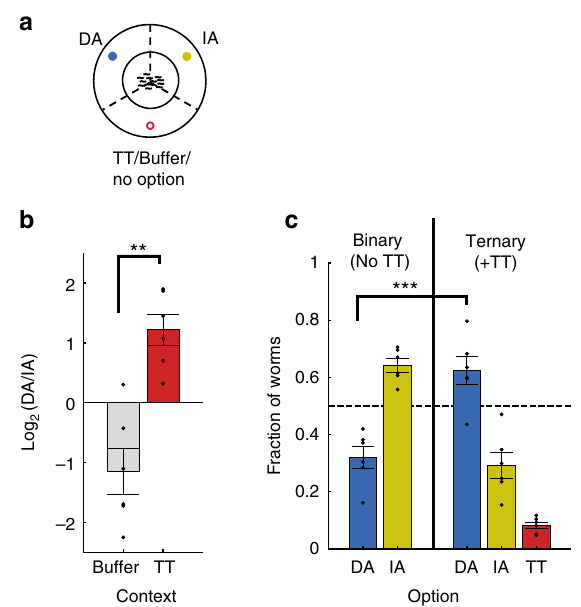
Fig. 7 C. elegans worms violate the rationality paradigms of IIA and regularity. a A diagram of the ternary choice assay. b Violation of Independence of Irrelevant Alternatives (IIA). For studying IIA, we compared preferences between two competing options (DA 7·10 – 5 and IA 10 − 1 ) where the third option was either TT 10 − 2 or buffer. The identity of the third option (TT vs buffer) changed the preference ratio between DA and IA, thus violating the constant-ratio rule 28 . In fact, it actually switched the identity of the preferred option, thus violating also choice independence of alternatives. Y axis is the log ratio between worms that chose DA and worms that chose IA. ** P < 0.005, signi fi cance of difference between buffer and TT as a third option (paired t test). Importantly, both log ratios are signi fi cantly different than 0 ( p < 0.05, t test), indicating that presenting TT, rather than buffer as a third option, switches DA/IA preference from IA to DA. c Violation of regularity. Shown are the fraction of worms selecting each option in binary and ternary choice assays. Note that expanding the set by adding TT not only increased preference towards DA but caused this preference to actually exceed 50%. ***signi fi cance of change by set expansion with P < 0.001 (paired t test). N = 6 experimental days for all conditions. In all panels, each experimental day is the average of 2 – 4 assayed plates. Scattered dots are the mean measurements in each experimental day. Error bars denote